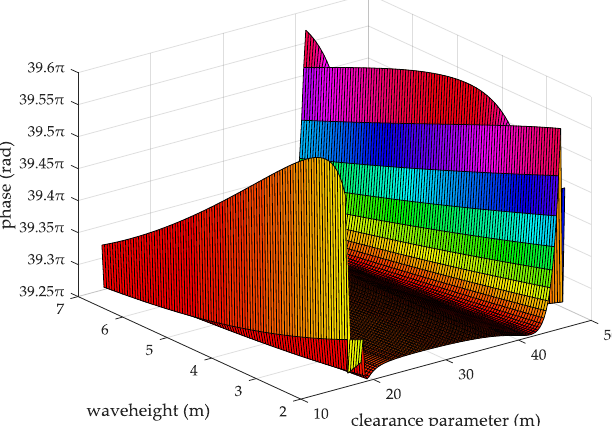
Figure 13. The ASFs of the AIS received signal changing with the wave heights and the clearance parameters.